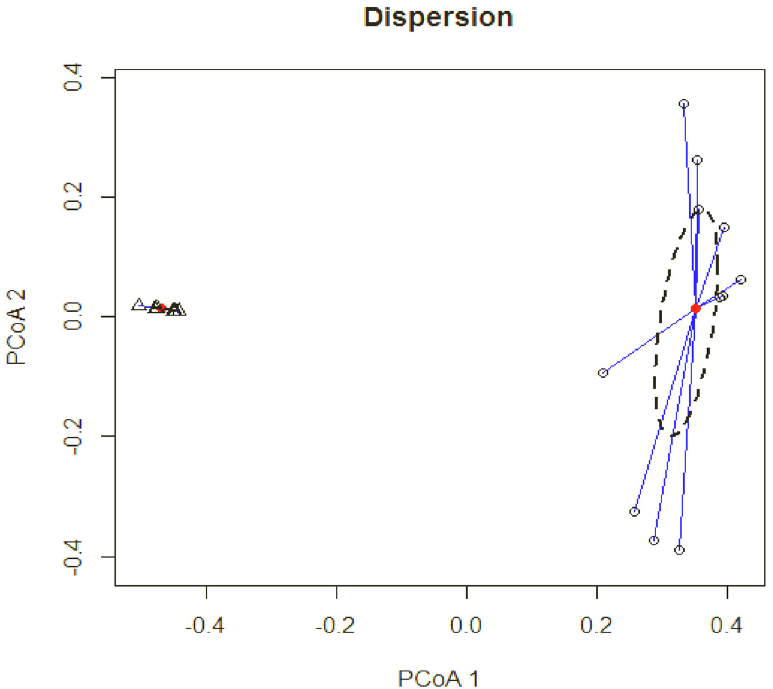
Figure 11. Scatter plot diagram of abundance data. The empty circles represent the Otonga sampling plots (right of diagram), the empty triangles the Otongachi sampling plots (left of diagram), the red dots represent the centroids. The axes PCoA1 and PCoA2 represent the first two principal components, while the dashed lines represent the 95% confidence interval.